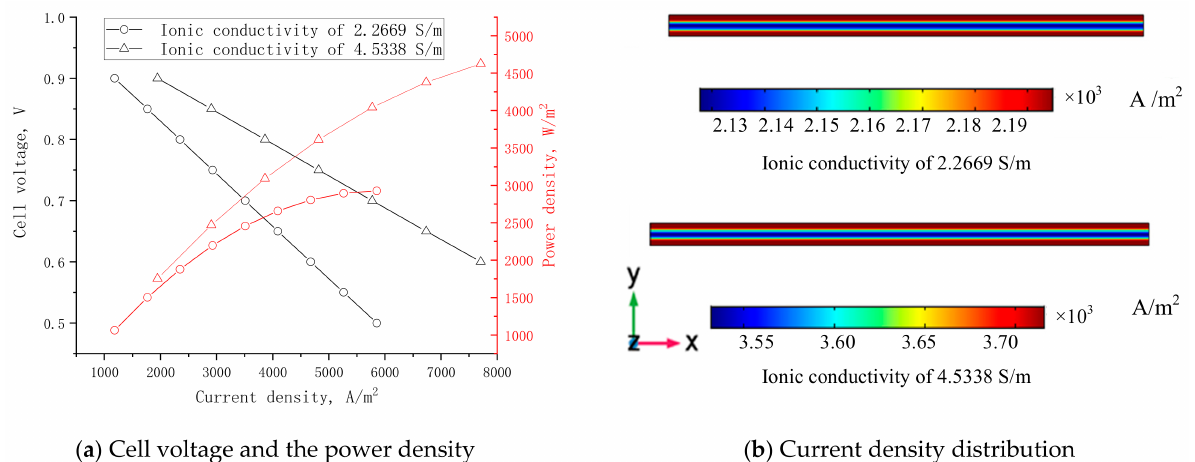
Figure 9. Comparison between two cases with different ionic conductivities: ( a ) cell voltage and the power density and ( b ) current density